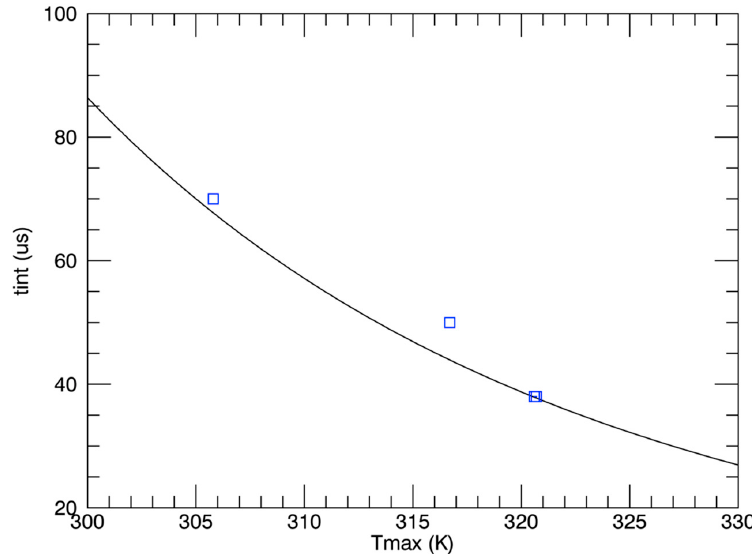
Figure 18. Comparison of measured (blue squares) against predicted (solid line) maximum brightness temperature T max vs. integration time for S7 channel. Table 10. SLSTR-A NEDT vs. integration time.